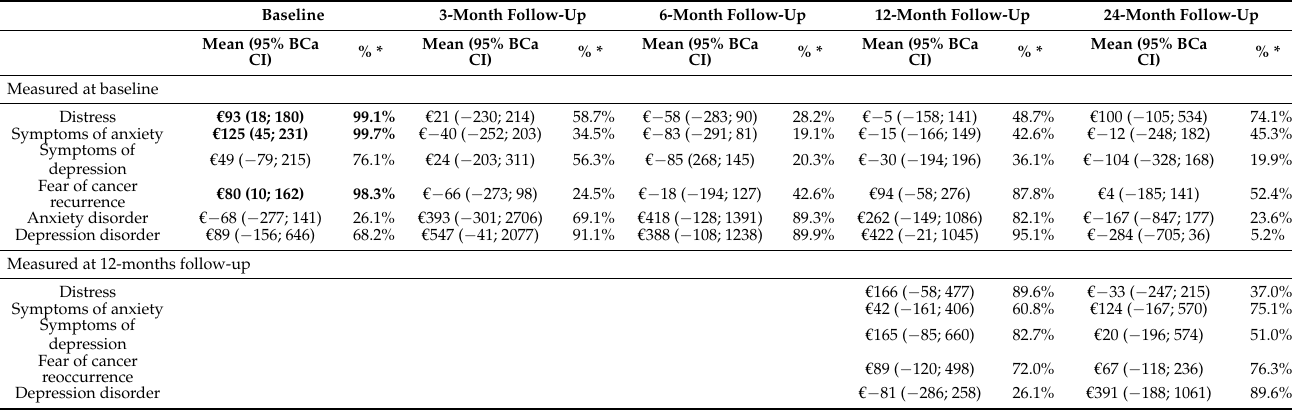
Table 4. Differences in costs at baseline, 3-,6-,12-, and 24-month follow-up between patients with and without psychological problems at baseline and 12-months